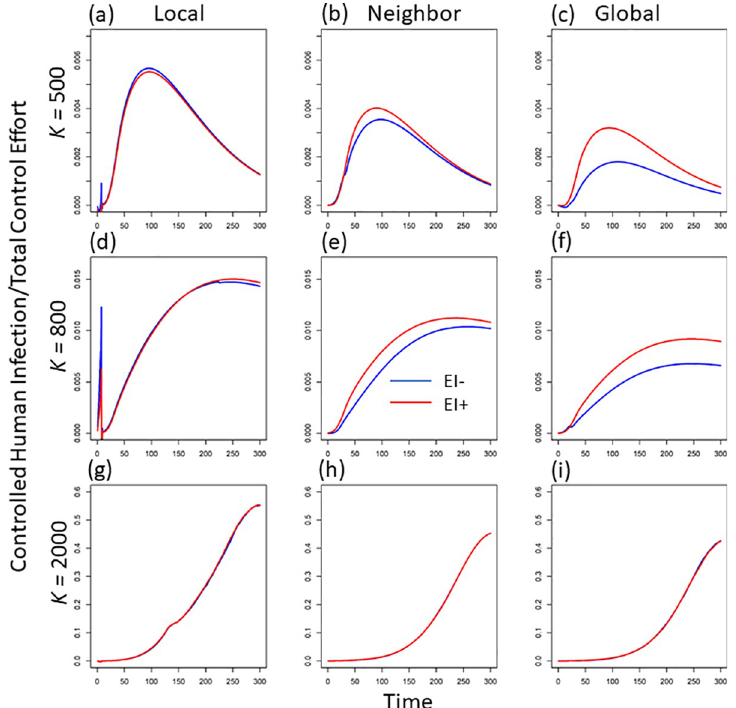
Fig 4. The dynamics of control efficacy (i.e., the reduction in human infections per unit of total control effort; unit: no. � time) per patch under three levels of mosquito breeding capacity (e.g., K = 500, 800 and 2000) and three scales of disease information (i.e., local, regional, and global scale). Here we exclude the patch where disease starts to get the average control efficacy in one patch. The blue lines indicate the dynamic in the absence of early intervention, while the red lines are the dynamics in the presence of early